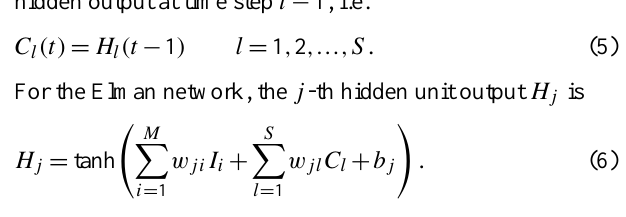
Fig. 3. Architecture of Elman neural network